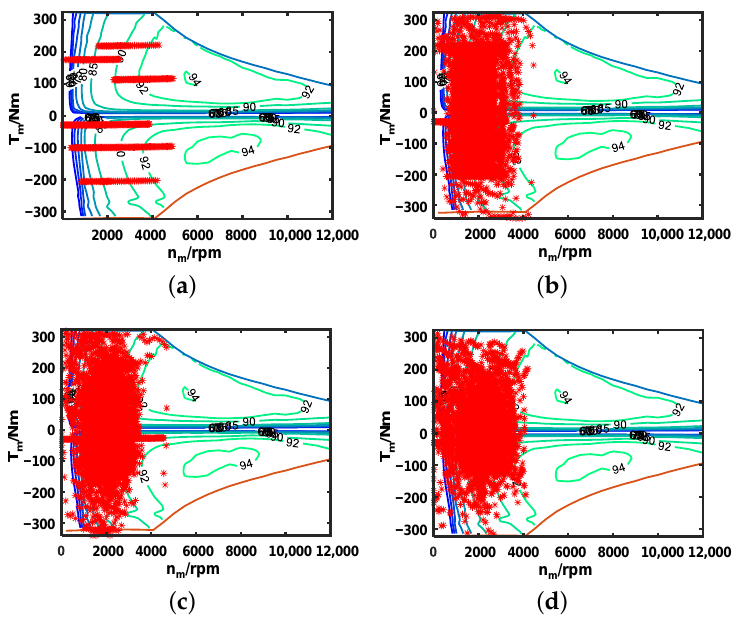
Figure 15. Distribution of motor operating points: ( a ) rule-based. ( b ) RL without considering energy saving. ( c ) RL without considering the prediction. ( d ) RL proposed in this paper.